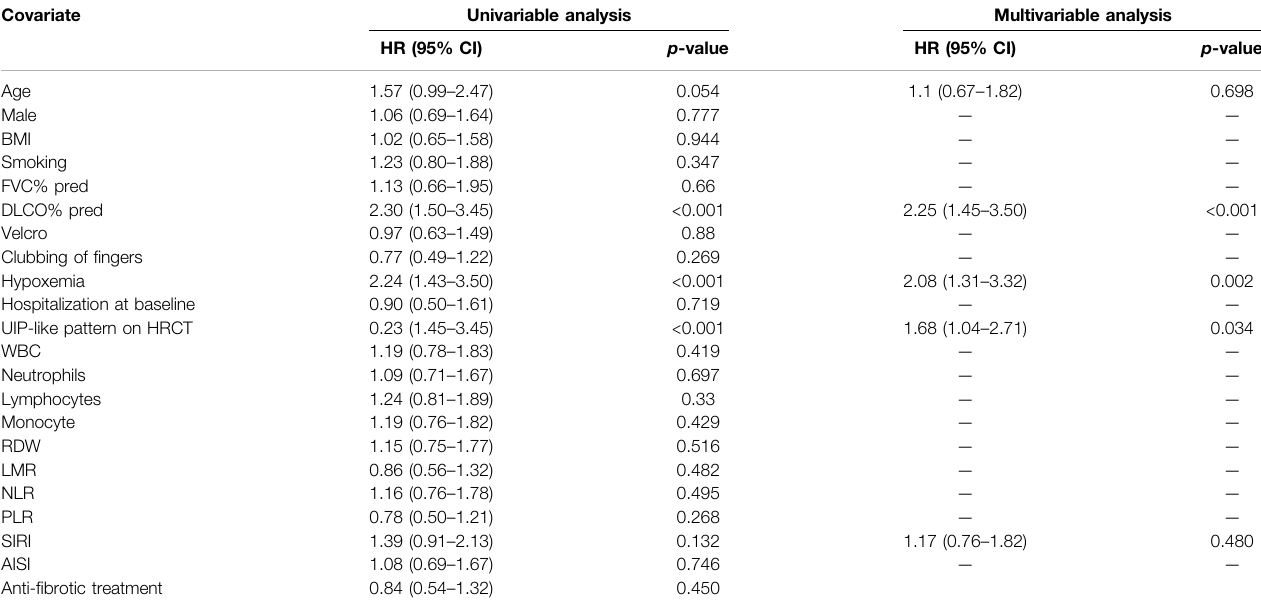
TABLE 4 | Factors associated with 6-year all-cause mortality in the PF-group.